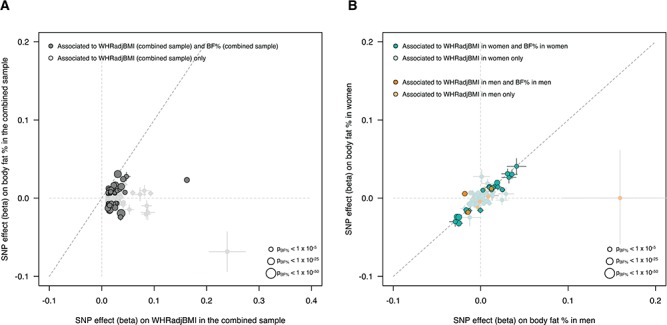
Effects of WHRadjBMI-associated SNPs on body fat percentage. (A) We investigated the impact of the 346 WHRadjBMI index SNPs (discovered in the combined analysis) on BF% in 449 001 UK Biobank individuals. Of the 346 SNPs, 59 (17.1%) are associated with BF% (P < 0.05/346 = 1.44 × 10−4, dark grey points). We oriented the effects of the SNPs to the WHRadjBMI-increasing effect and found that 34 of the 59 BF%-associated SNPs associate with increased BF%, while 25 of the 59 associate with decreased BF%, indicating that WHRadjBMI-associated SNPs can affect BF% in both directions. (B) Given the sex-dimorphic signature observed in WHRadjBMI-associated SNPs and the increased number of SNPs with stronger effects on WHRadjBMI in women, we investigated the effect of the 105 sex-dimorphic index SNPs identified from the three meta-analyses (in the combined sample, in women only, in men only) on BF% in men or women separately. Of the 105 dimorphic SNPs, 97 were female specific (aquamarine points) and conferred a stronger effect on WHRadjBMI (on average) compared to the eight male-specific SNPs (orange points). We plot the 105 sex-dimorphic SNPs by their effect on BF% in men (x-axis) and in women (y-axis). Of the 105 SNPs, 56 associate with BF% (P < 0.05/05 = 4.8 × 10−3). Despite the fact that these SNPs confer different effects on WHRadjBMI within sex-specific groups, we found that they confer relatively similar effects in BF% in sex-specific groups. All points are scaled in size to their strength of association in BF%.